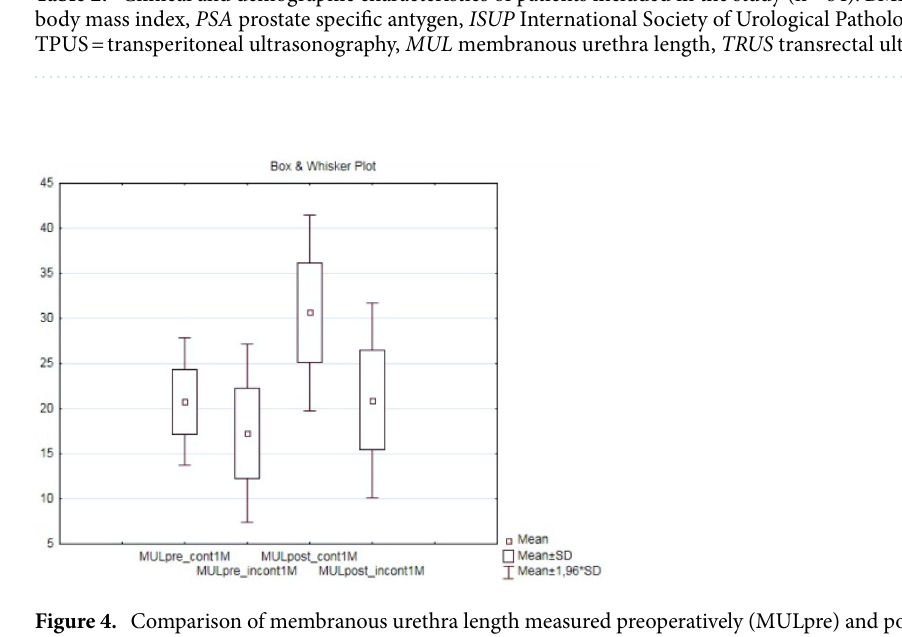
Figure 4. Comparison of membranous urethra length measured preoperatively (MULpre) and postoperatively (MULpost) in a subgroups of patients continent (cont 1 M) and incontinent (incont1M) wihtin one month after catheter removal; (CI 95%, p =